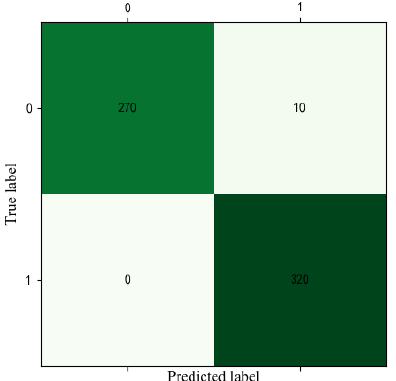
Figure 14. The confusion matrix of the proposed method on the experimental dataset.